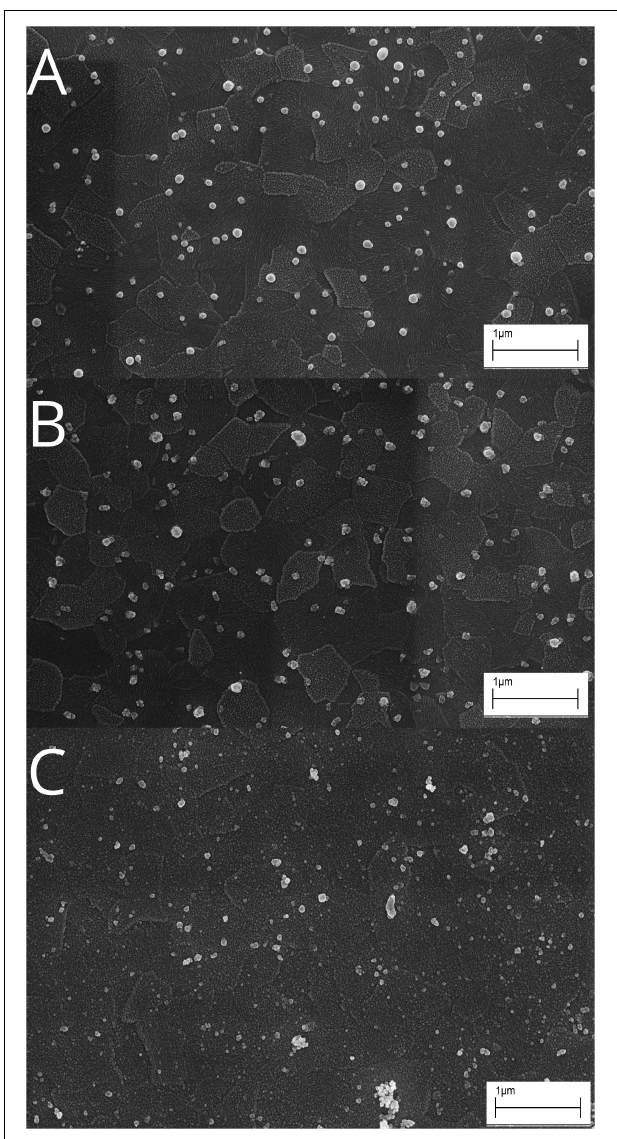
FIGURE 5 | Representative scanning electron microscopy (SEM) images of particle morphology observed on indium tin oxide (ITO) electrodes in NP14 Glass Wool (A) , NP14 Basalt (B) , and NP14 fluid control (C) on termination of incubations indicates very small coccoid-shaped particles, possibly cells, adhering to the electrodes in the live samples. Scale bars 1